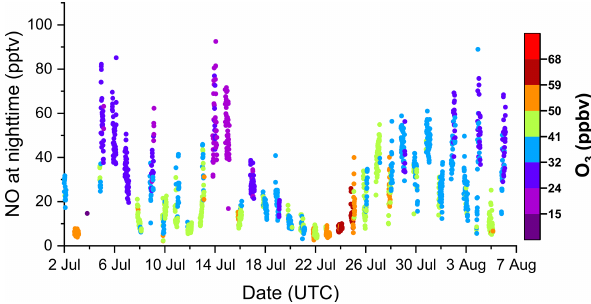
Figure 8. Nighttime NO mixing ratios (colour-coded by O 3 mixing ratios) during TO2021. The x -axis ticks represent 00:00UTC.